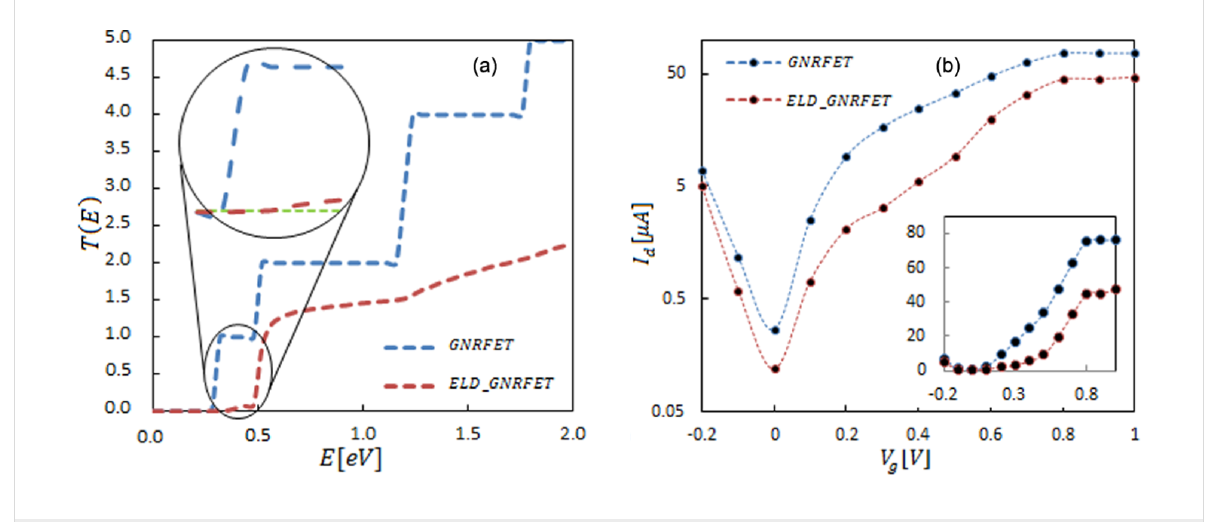
Figure 2: (a) Comparison between average transmission probabilities as a function of the energy in 1.8 × 20 nm armchair graphene nanoribbons. Inset shows transmission probabilities compared to the minimum effective band structure transmission (dashed green). (b) I d vs V g characteristics (logarithmic scale) for ELD-GNRFET (dashed red) and GNRFET (dashed blue) containing a 1.8 × 20 nm armchair graphene nanoribbon channel. The inset shows linearly scaled transfer characteristics. ( I on extracted from I ds at V gs = V off + V DD ( V DD = 0.7 V), where V off = V gs at I ds = I off ). Symbols show the exact value, and dashed lines are fitted to data points.